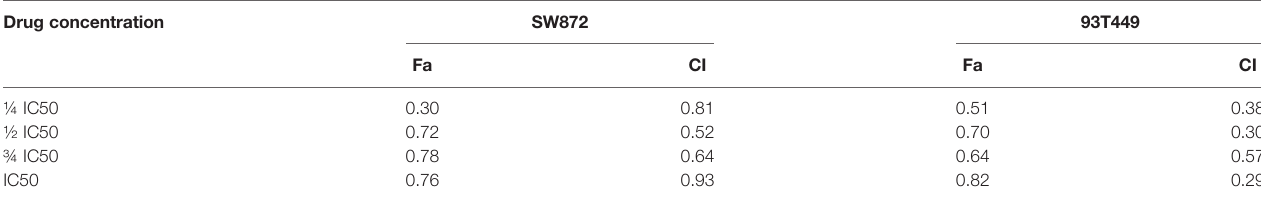
TABLE 3 | Synergistic inhibition of Apatinib and Epirubicin in liposarcoma cells. Drug concentration